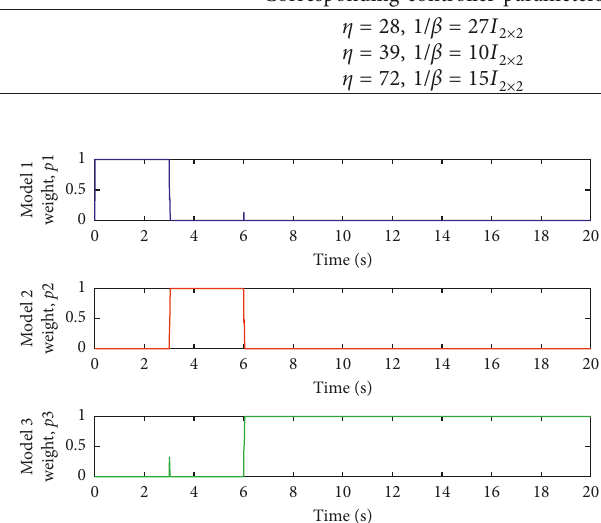
Figure 12: The weights for the local controllers of the WMNNAC system.